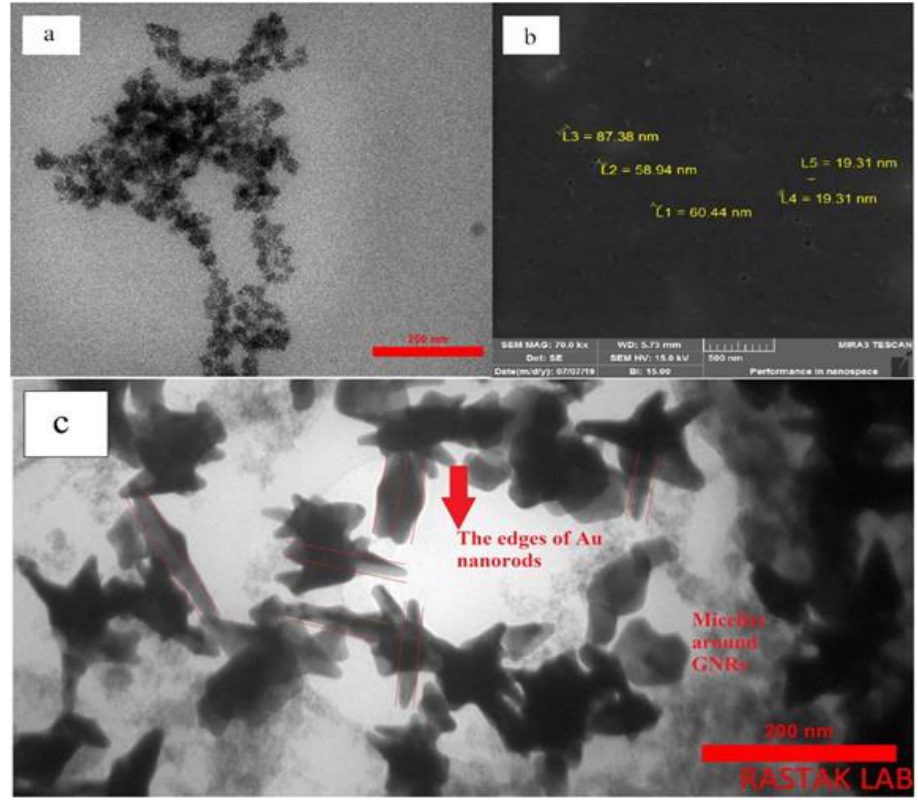
Figure 8. ( a ) TEM image of polymeric micelles, ( b ) SEM image of AuNRs, and ( c ) TEM image of AuNRs coated by polymeric micelles. Adapted from ref. [69], copyright 2020, with permission from Elsevier.